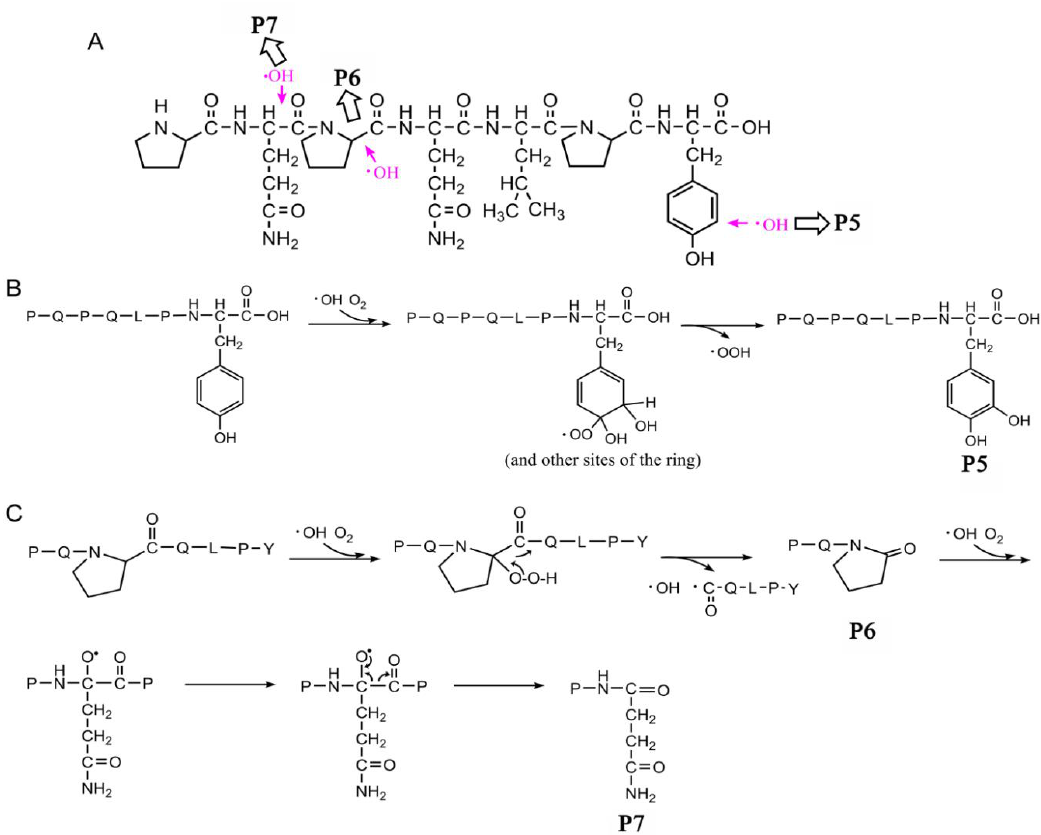
Figure 7. Structures of the celiac-toxic peptide PQPQLPY and its CJAP plasma-modified fragmentation products referred to in this research (P5~P7), which were detected by Orbitrap HR-LC-MS/MS. ( A ) Structural changes in PQPQLPY during CJAP plasma treatment. The arrow shows the